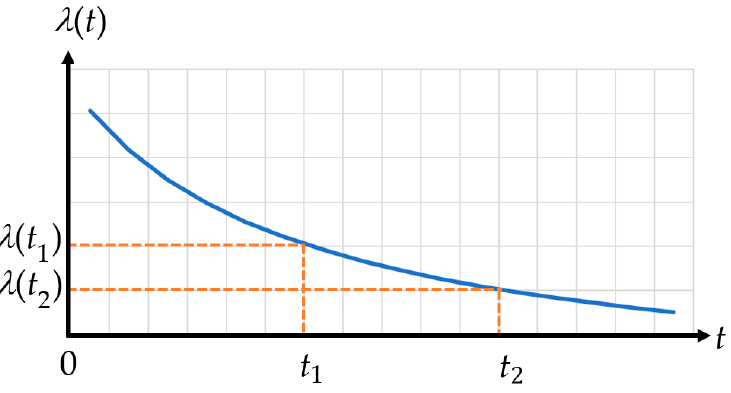
Figure 2. Decreasing failure rate, k λ < 1.